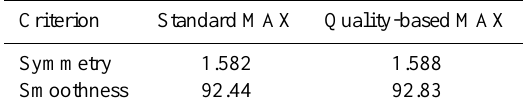
Table 3. Criteria of reliability of standard and quality-based MAX products (Brzuchania radar, May–June 2014).